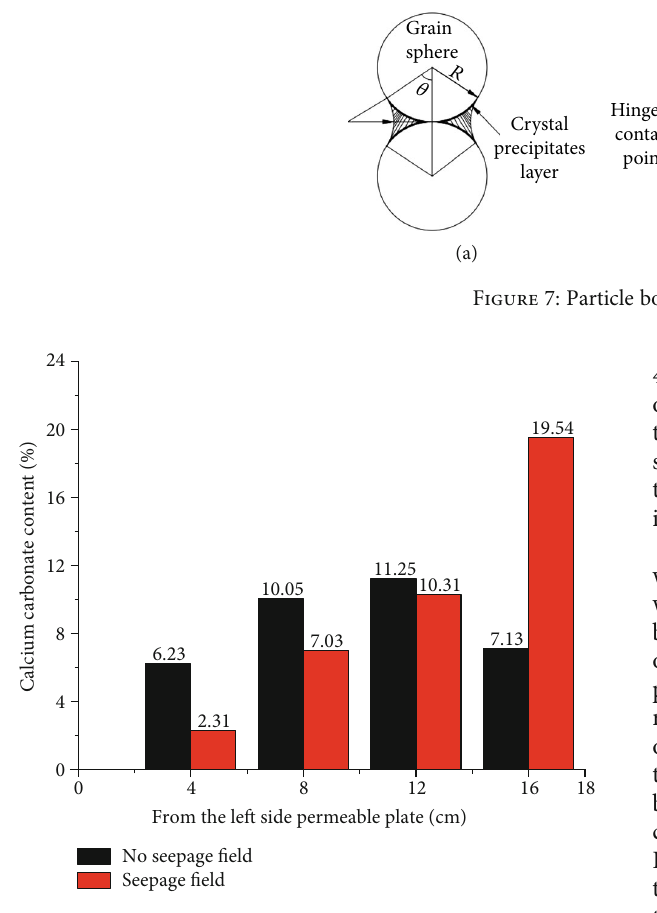
Figure 8: Calcium ion content of each